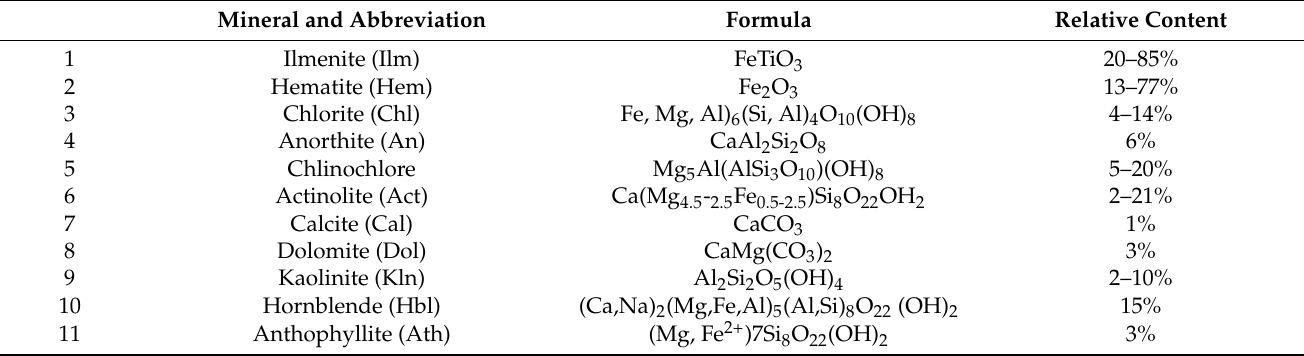
Table 2. Identified mineral phases in Fe-Ti oxides.